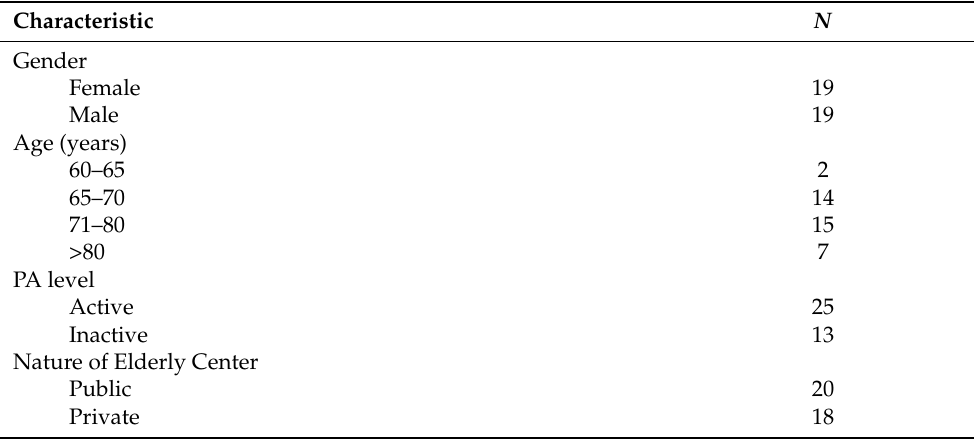
Table 1. Characteristic of